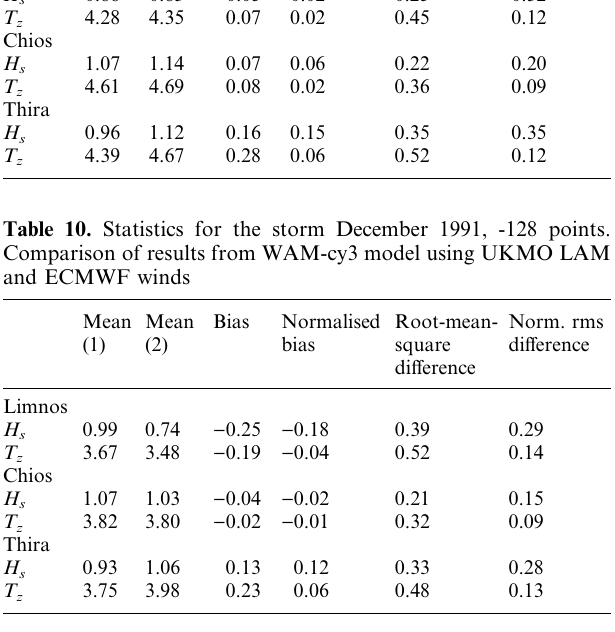
Table 11. Statistics for the storm December 1991, -128 points. Comparison of results from WAM-cy4 model using UKMO